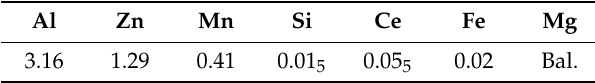
Table 1. Chemical composition of the alloy in